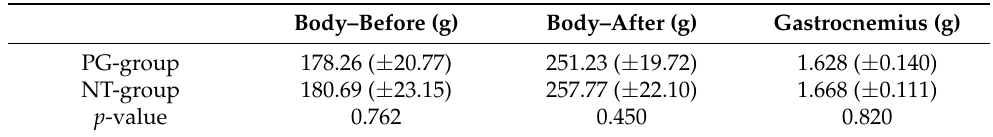
Figure 2. Serum IgG antibody titers in response to P. gingivalis .